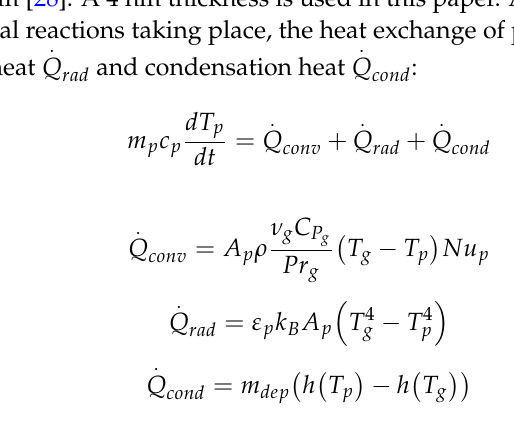
Figure 3. Configuration showing an Al particle ignition and combustion procedure.